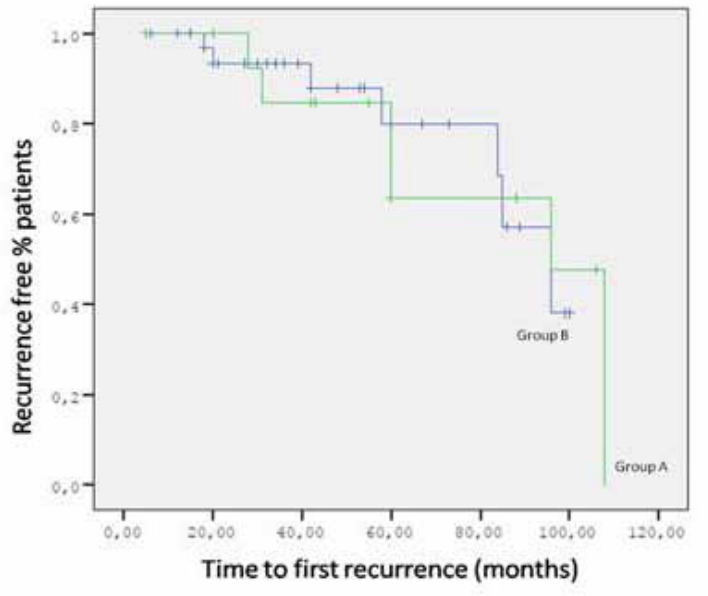
figure 1 - Kaplan-Meier analysis for recurrence-free